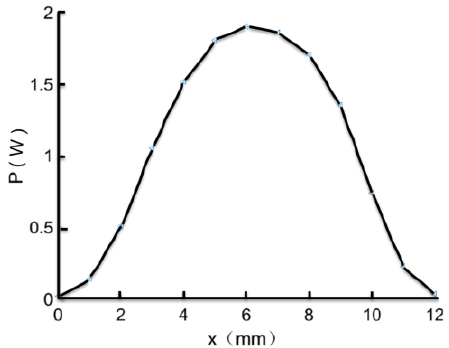
Figure 4. Gaussian distribution of the laser.